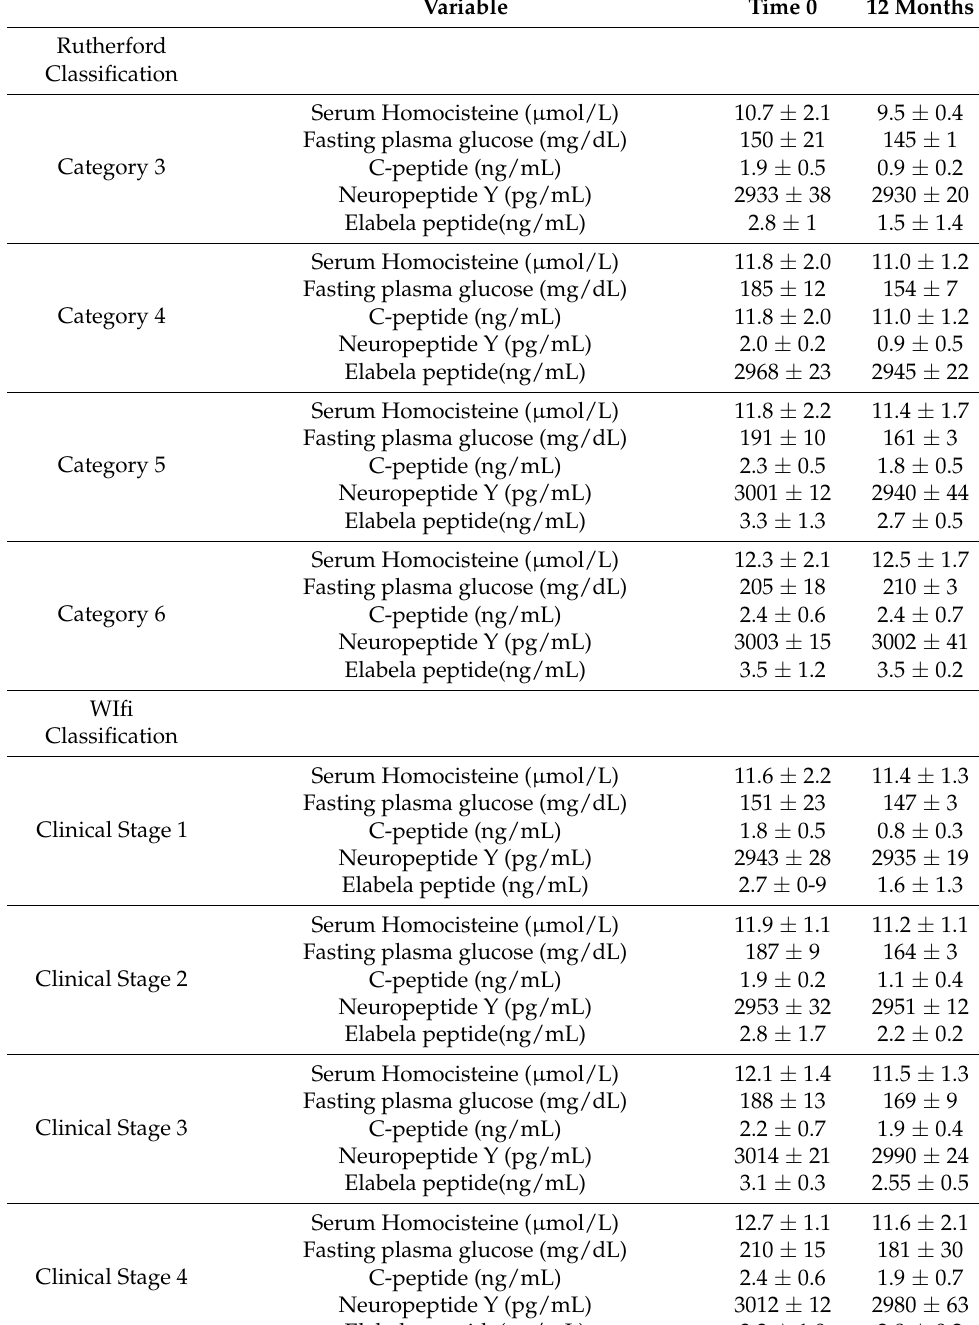
Table 5. Clinical presentation and